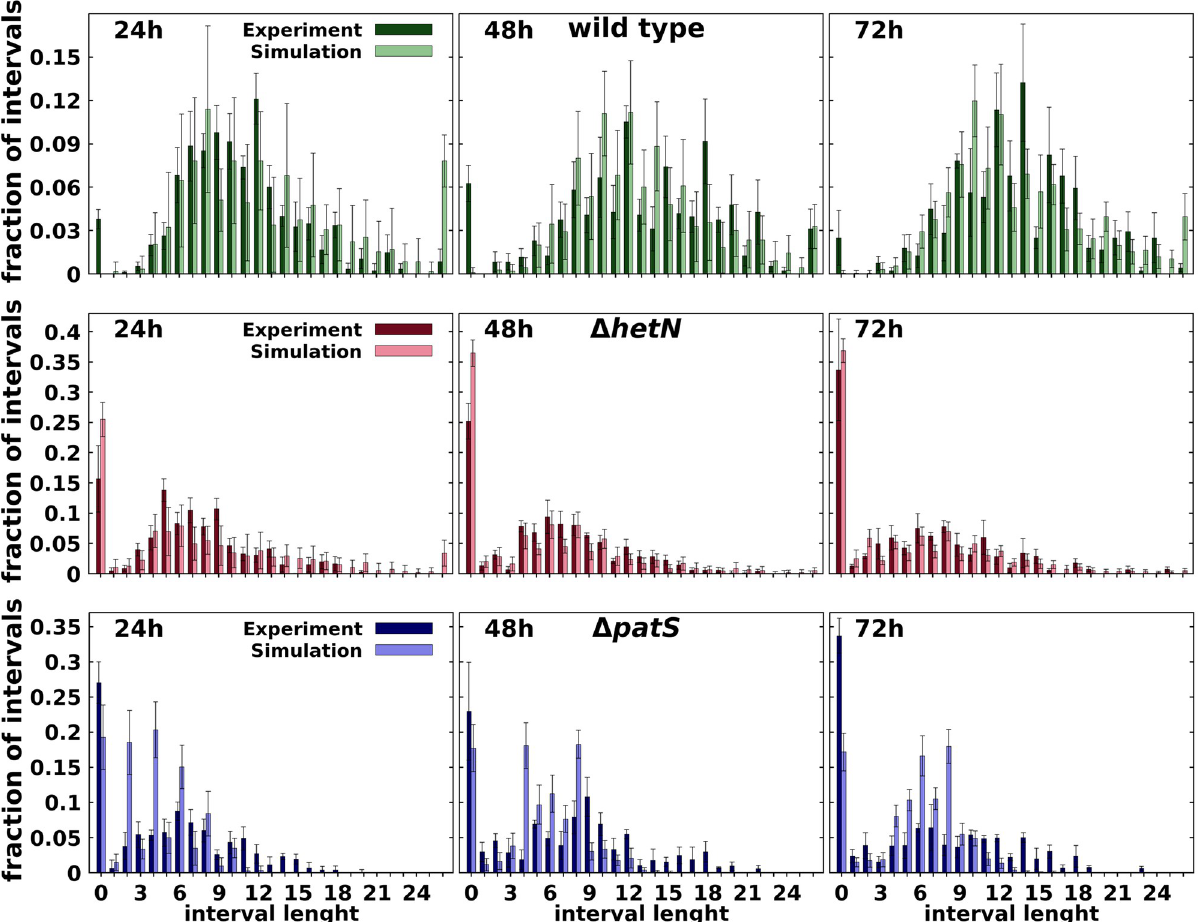
Fig 4. Comparison at different times after nitrogen deprivation (as indicated) between experimental [50] and simulated histograms of the number of vegetative cells between heterocysts for wild type (top row), Δ hetN (middle row), Δ patS (bottom row). Bars are means of interval lengths, errors are standard deviations. For details of calculations see the Statistics